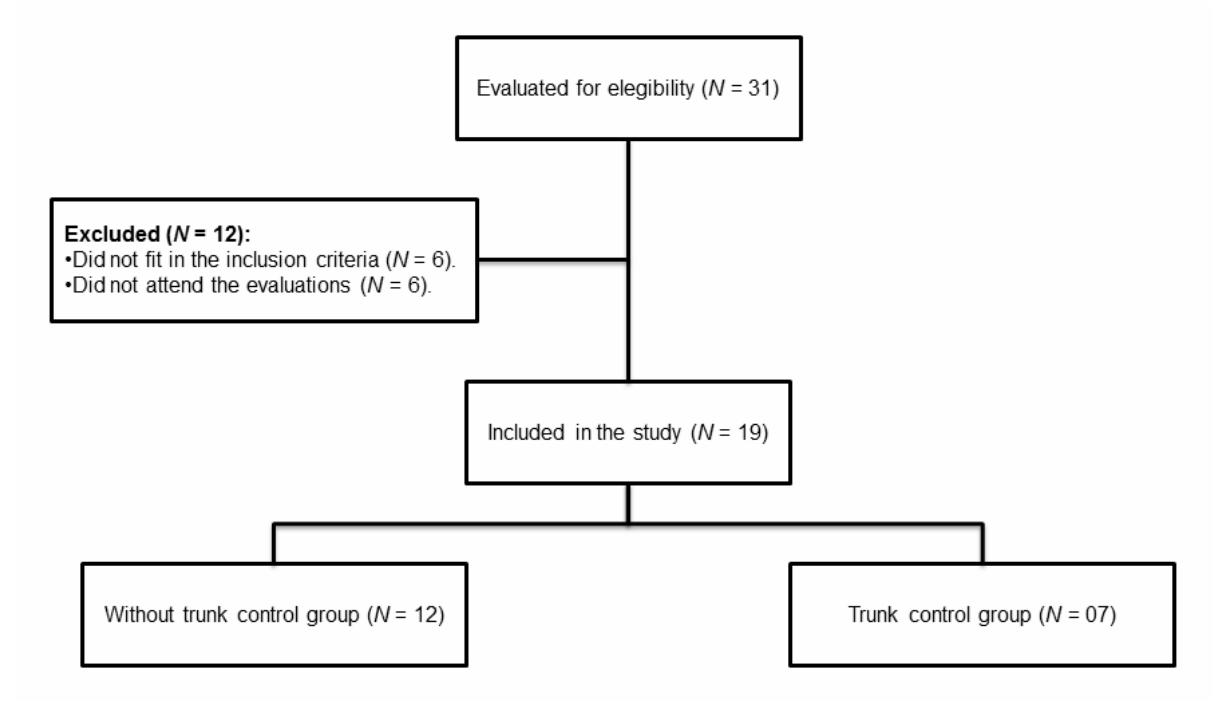
Figure 1. Flowchart presenting sample loss in the